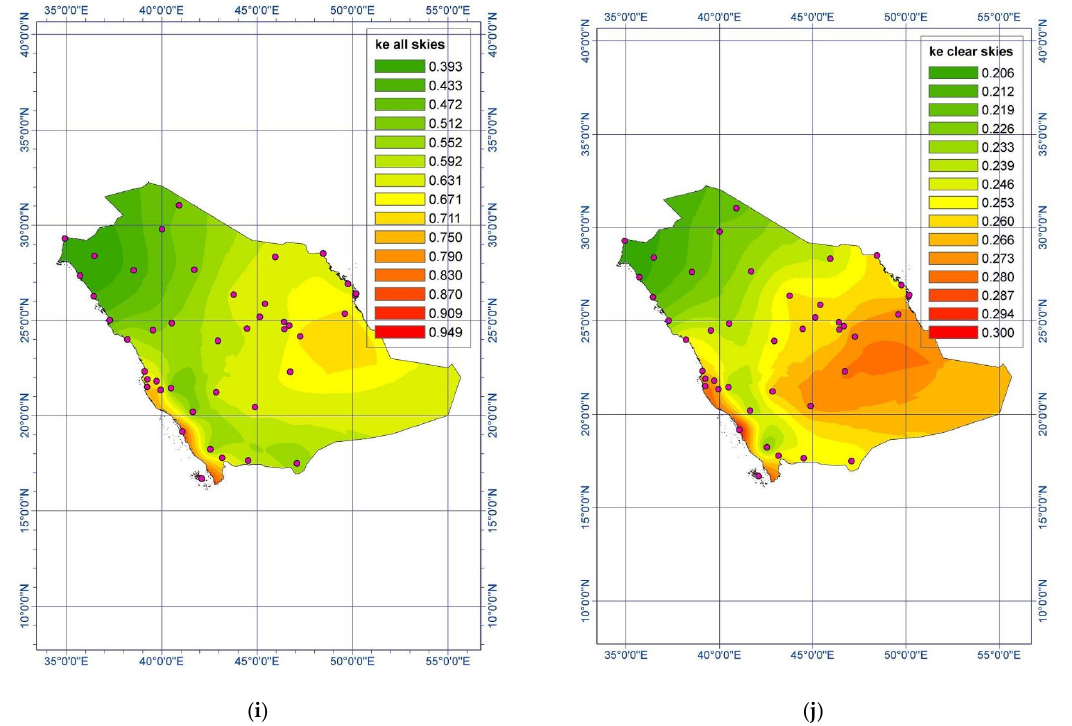
Figure 12. Maps of Saudi Arabia showing the distribution of the annual mean values of the parameters ( a , b ) G, ( c , d ) G d , ( e , f ) k d , ( g , h ) k b , and ( i , j ) k e , averaged over the period 2013–2021. The left panels depict all-sky and the right panels depict clear-sky conditions. The purple dots indicate the location of the 43 sites. Beside each map, the color code indicates the lowest (green) to the highest (red) values. The distribution of the diffuse horizontal irradiance throughout Saudi Arabia is